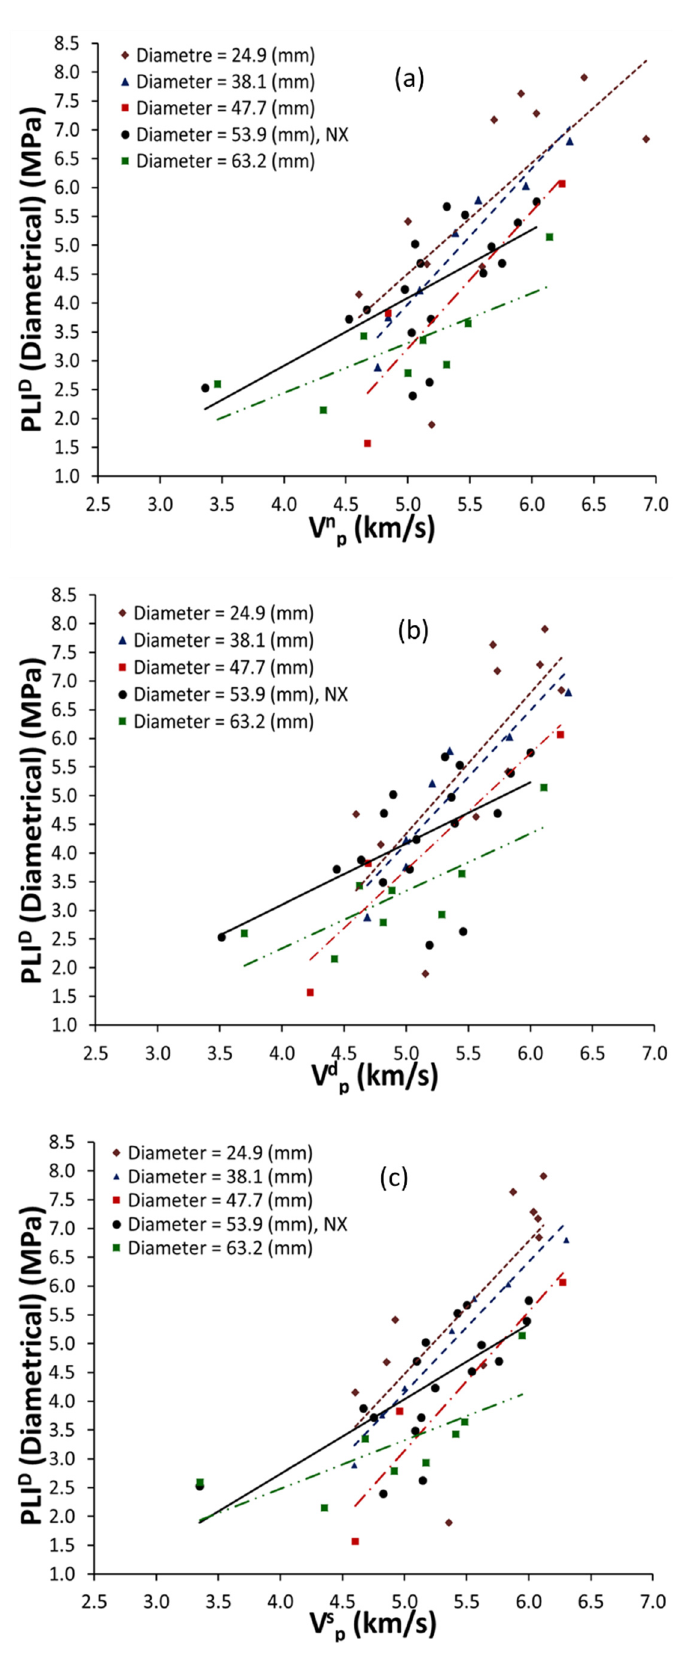
Figure 2. Variation in PLI D values. PLI D plotted as a function of ( a ) V np , ( b ) V dp , and ( c ) V sp for different sample diameters.